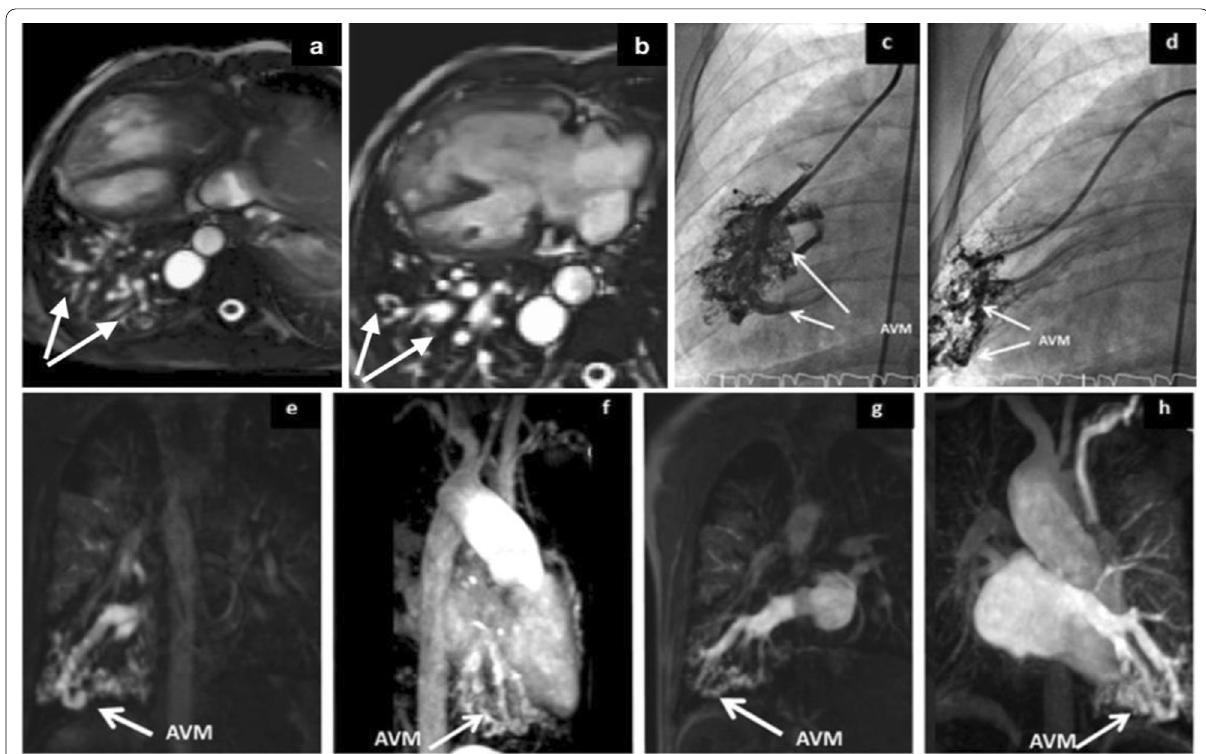
Fig. 15 A large right-sided pulmonary AVM in a patient with a Fontan circulation. a , b Axial still shots of MRI SSFP cine sequences demonstrating a pulmonary AVM in the right lower lobe, c , d catheter angiogram confirming the presence of an AVM, e – h contrast-enhanced MRI angiogram in coronal planes demonstrating the AVM (white arrows). AVM: arteriovenous malformation. Re-used with permission from Fontan circulation in an adult: A guide for the radiologist. Arzanauskaite M, Nyktari E, Voges I. ESTI-ESCR 2018 /